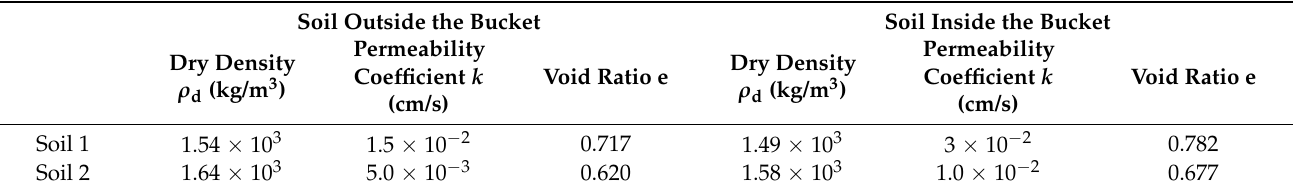
Table 3. Basic properties of the standard sand in this study.